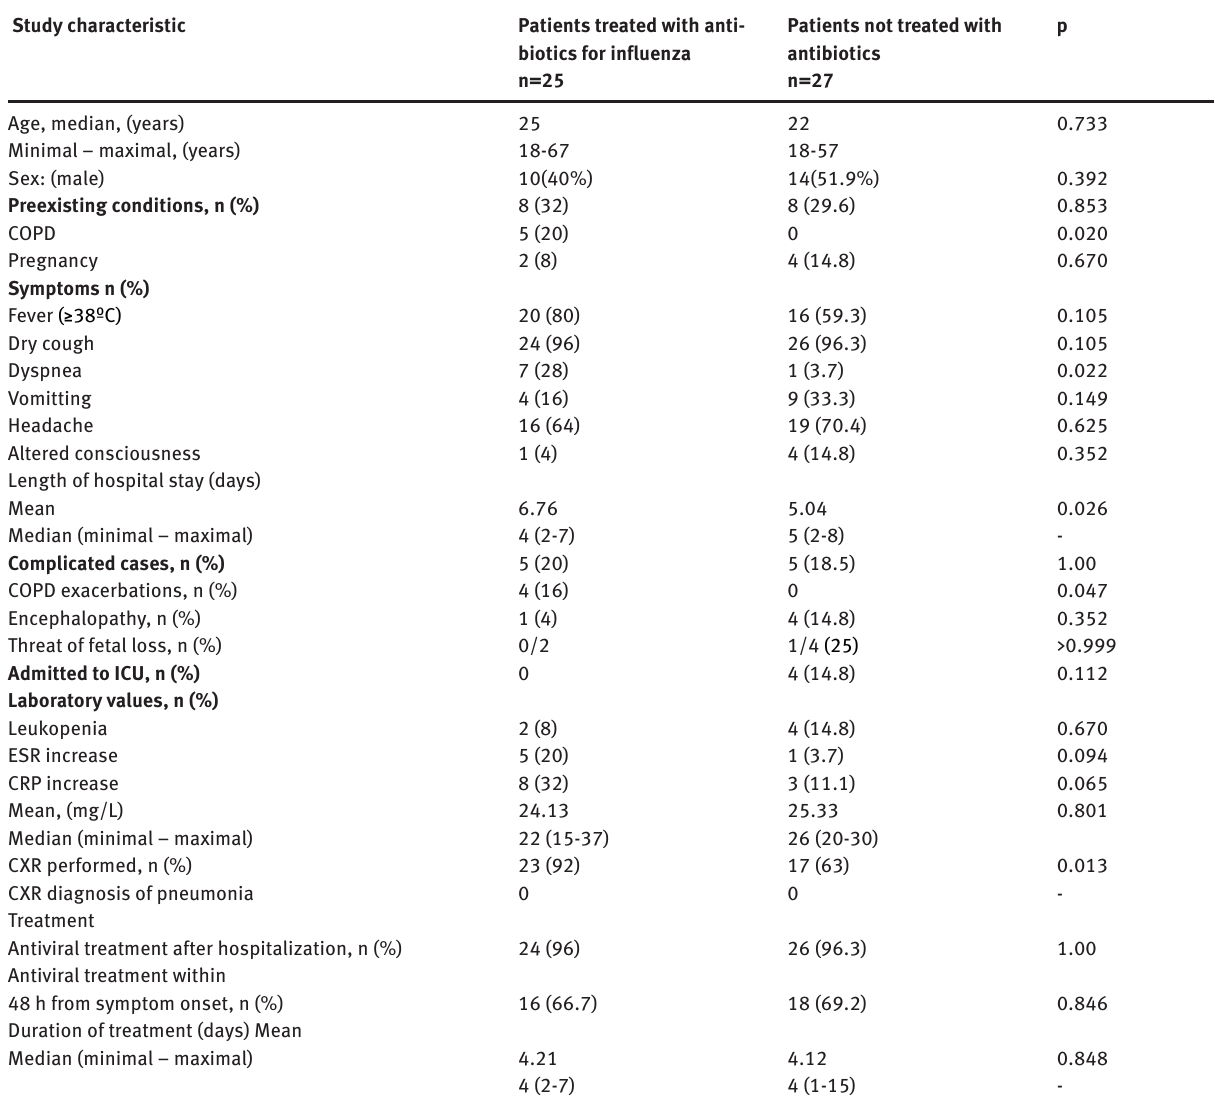
Table 4: Comparison of frequency of selected study characteristics in treated with antibiotics for influenza patients group with patients group not received